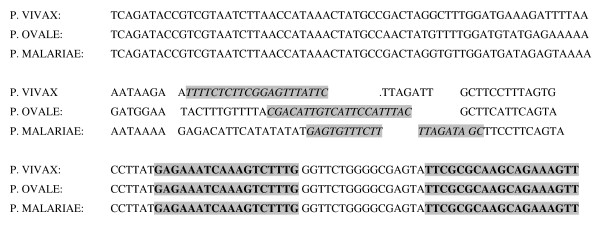
Alignment of sequenced 18SrRNA gene. Forward primers used in the different assays are shown in italics. Beacon and reverse primers are shown in bold.